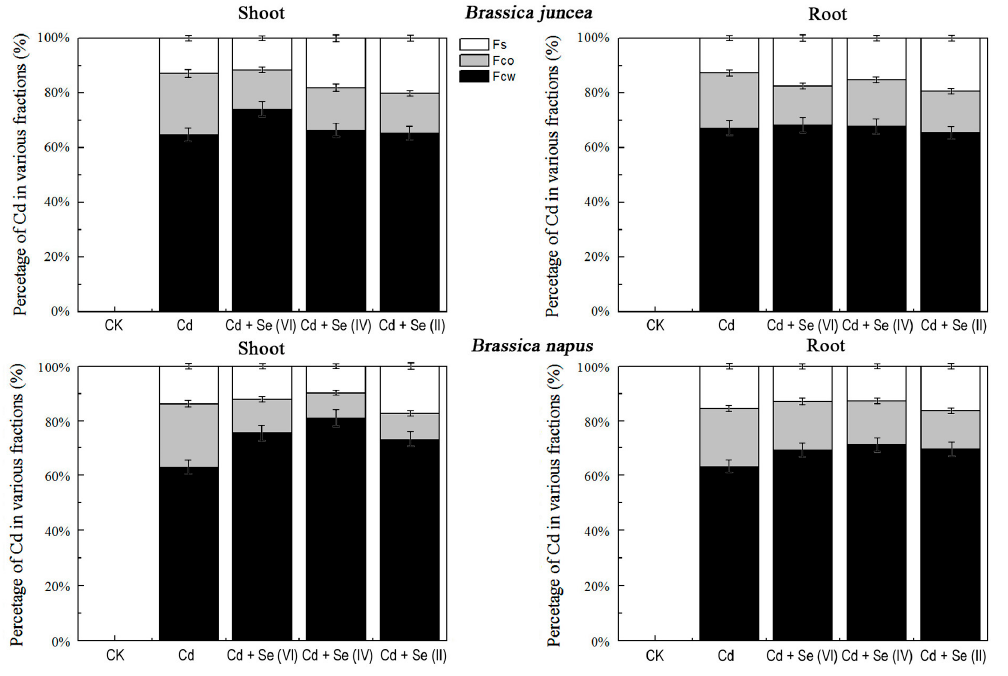
Figure 6. Percentage of Cd content in subcellular distribution of root and shoot in the two Brassica species. Fcw, cell wall fraction; Fs soluble fraction, Fco, organelle part fraction. The percentages are mean ± SD ( n = 3).